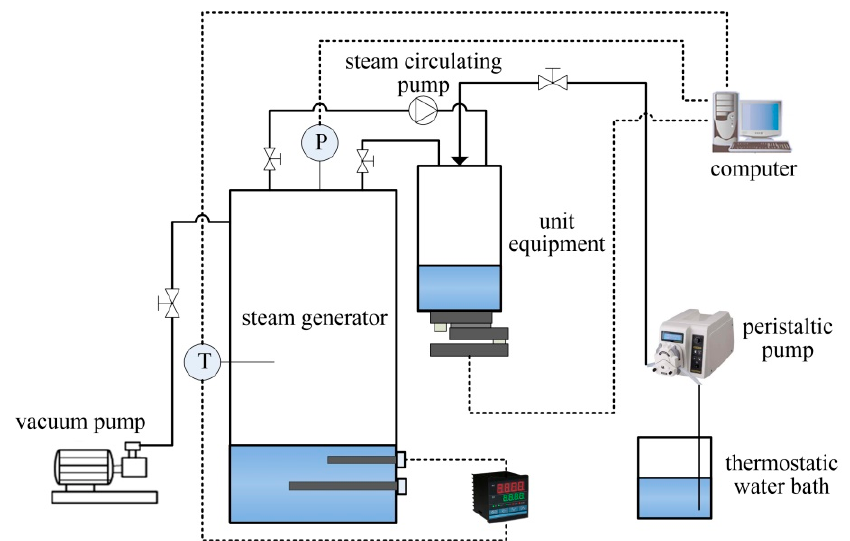
Figure 4. Schematic diagram of the weighing system.